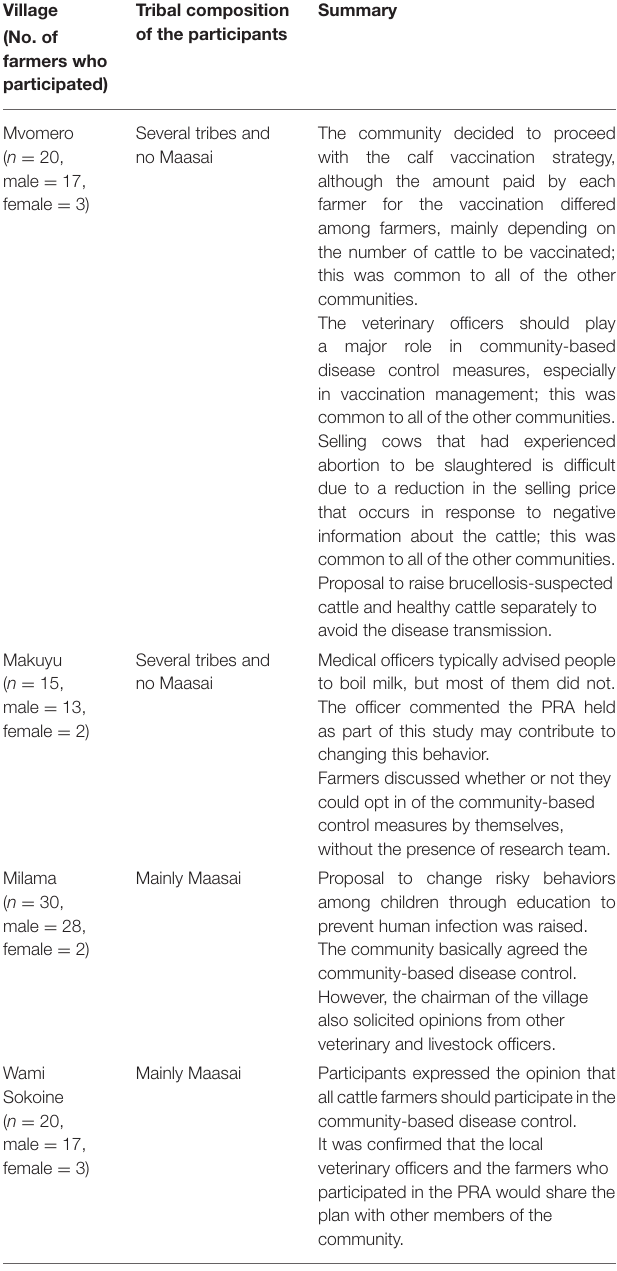
TABLE 2 | General information about the farmers who participated in the PRA and a summary of the discussion about community-based disease control in each community.